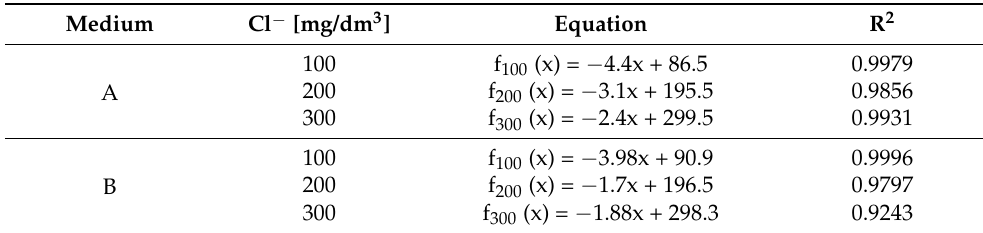
Table 5. The equations and correlation coefficients for the model describing changes in chloride ion